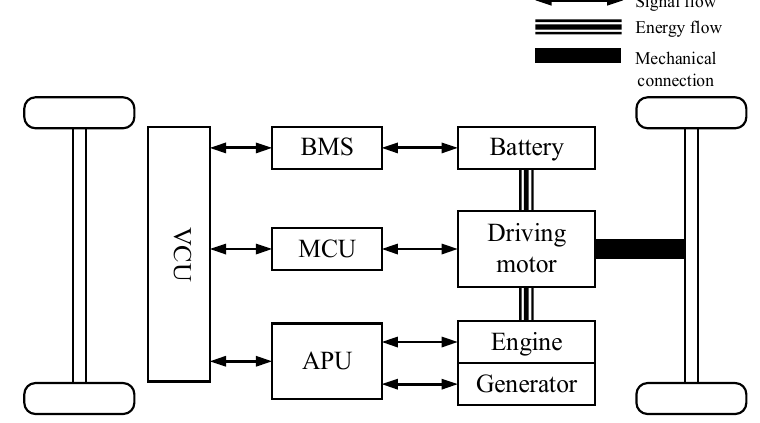
Figure 1. Auxiliary power unit (APU) power system. BMS: Battery Management System; MCU: Motor Control Unit.